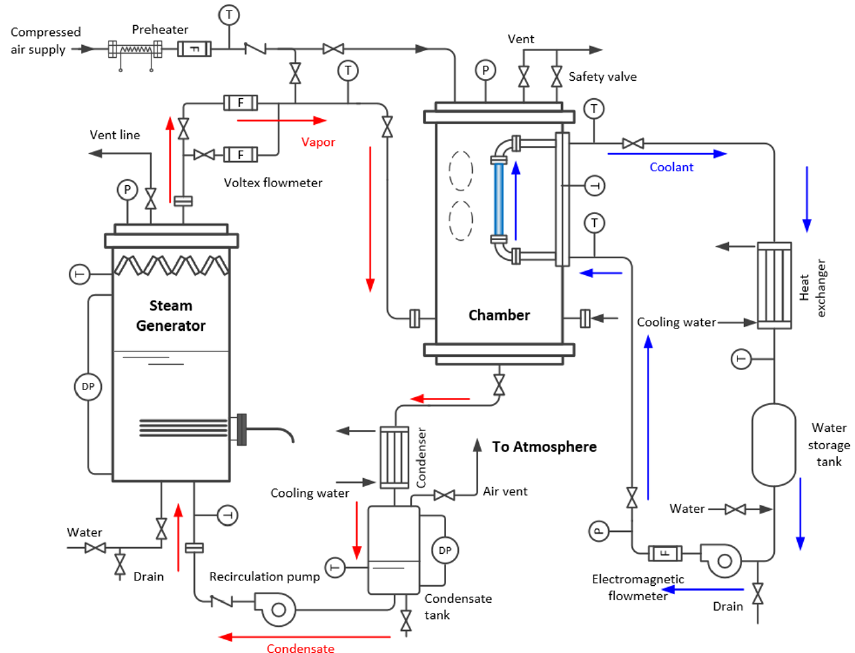
Figure 2. Schematic diagram of the condensation experimental facility.